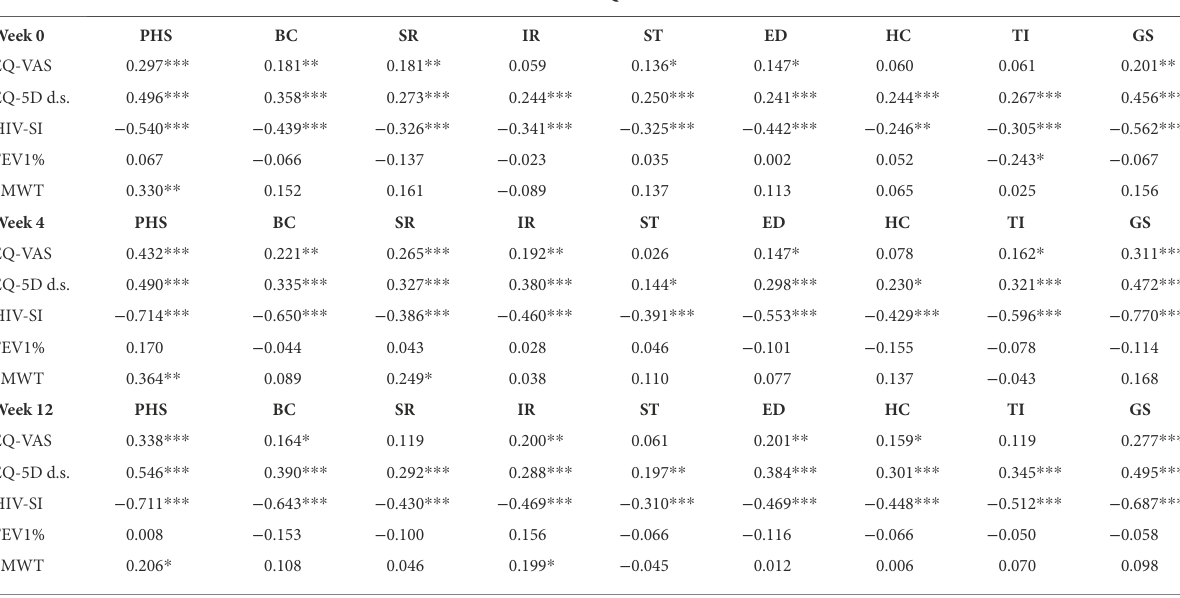
TABLE 4 Correlations between the HRQOL subscales and the global score and the relevant correlates: (1) EQ-5D descriptive system (d.s.), (2) EQ- VAS, (3) the HIV-SI, and the results from (4) the lung function test (FEV 1%) and (5) the 6 min walking test (6MWT). PROQOL-HIV/TB